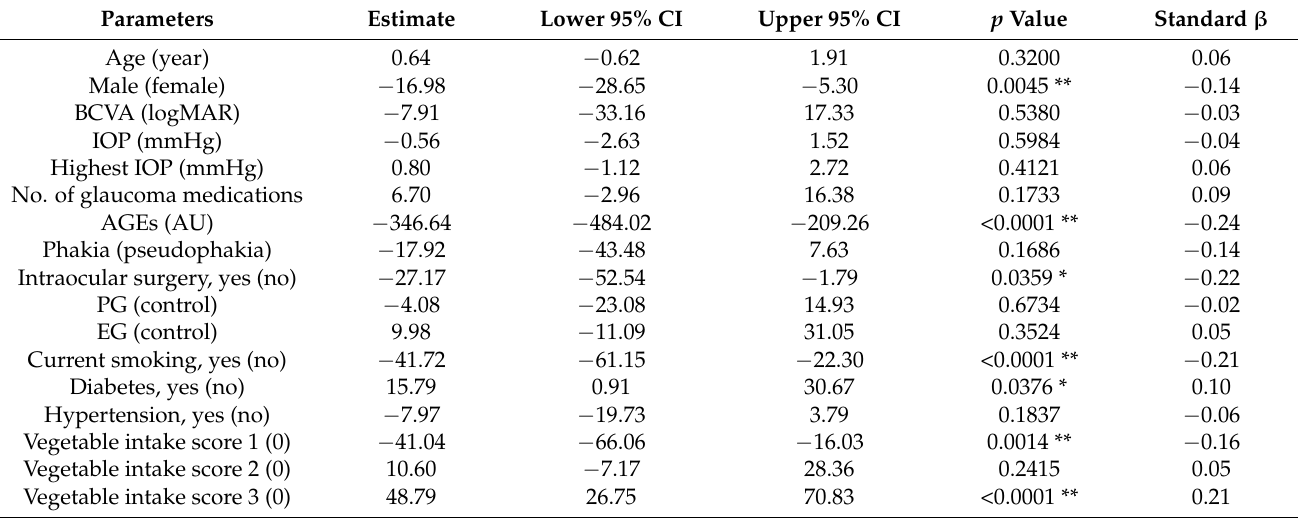
Table 7. Possible associations among SCs and various parameters analyzed by multiple regression